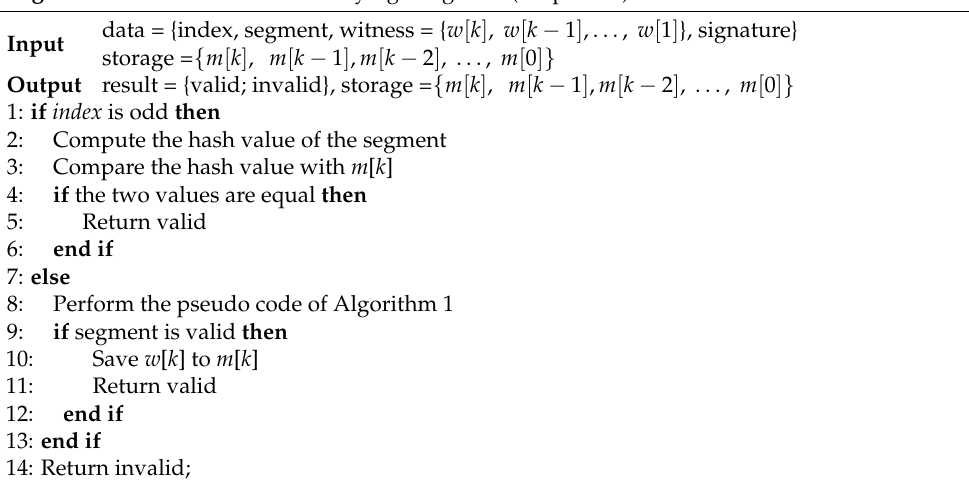
Algorithm 2 : Pseudo code for verifying a segment (Proposal